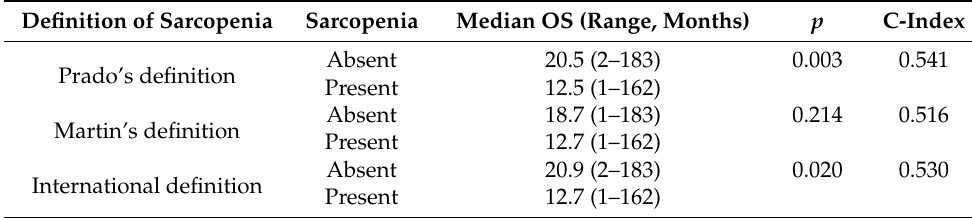
Table 3. Median overall survival and concordance index for each definition of Sarcopenia.